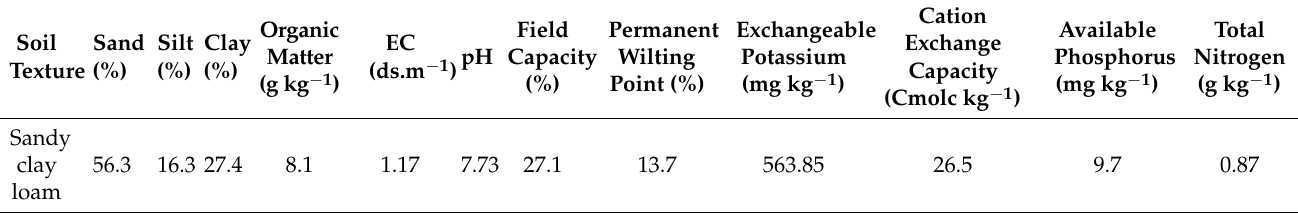
Table 6. Physico-chemical properties of field soil on average over the 2